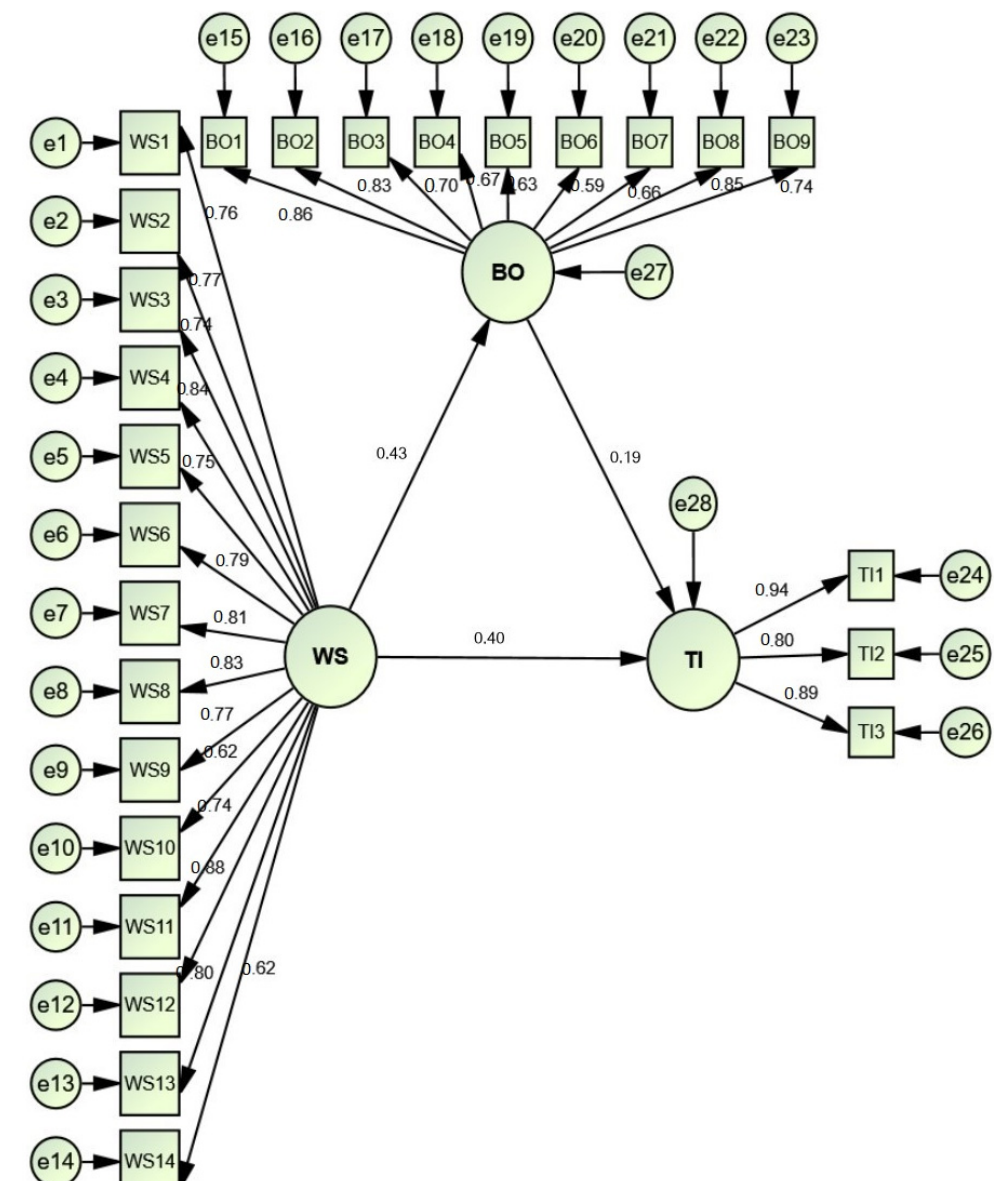
Figure 3. The structural model. Table 4. Structural Parameter Estimates.